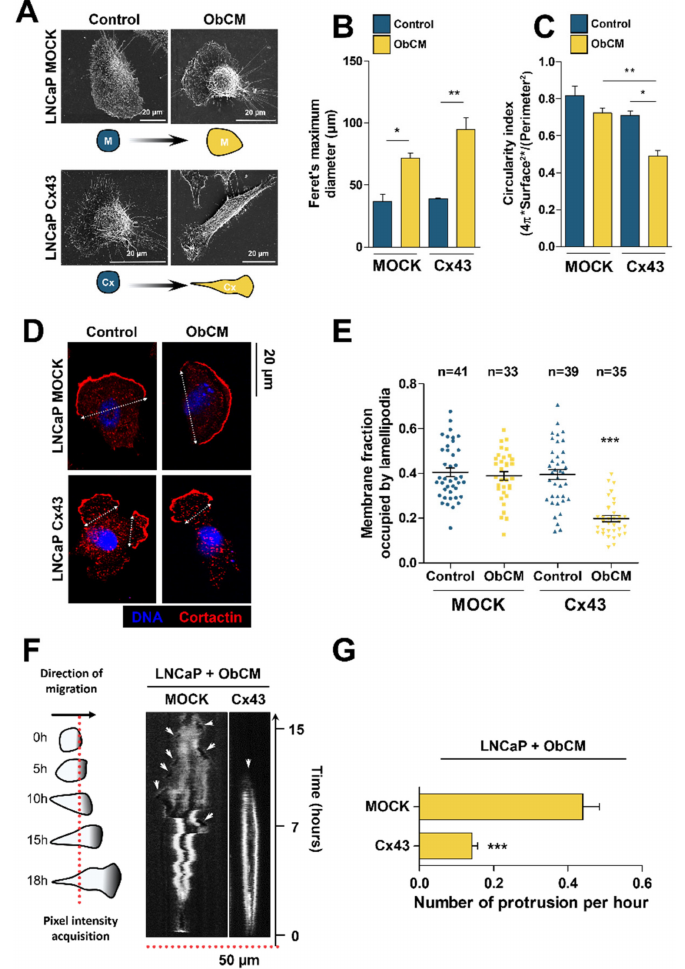
Figure 4. ObCM induces protrusive membrane dynamic in LNCaP Cx43 cells. Representative scanning electron microscopic images of LNCaP cells after 17 h of stimulation with or without ObCM ( A ) and associated quantification of cell morphology with Feret’s maximum diameter ( B ) and circularity index ( C ). Data represent the mean ± SEM from 3 di ff erent experiments. ( D ) Immunostaining of cortactin (red) highlighting lamellipodia in LNCaP cells after 17 h of stimulation with or without ObCM; nuclei were DAPI-stained (blue). ( E ) Quantification of the membrane fraction occupied by such membrane specialization. Data represent the mean ± SEM from indicated number of quantified cells. ( F ) Representative kymographs from LNCaP cells upon ObCM stimulation showing protrusion dynamics over time on a single image; red dotted line represents ROI used to perform the x-t scan necessary to generate such a graph. ( G ) Quantification of the mean number of protrusions emitted by one cell per hour. * p < 0.05; ** p < 0.01; *** p <